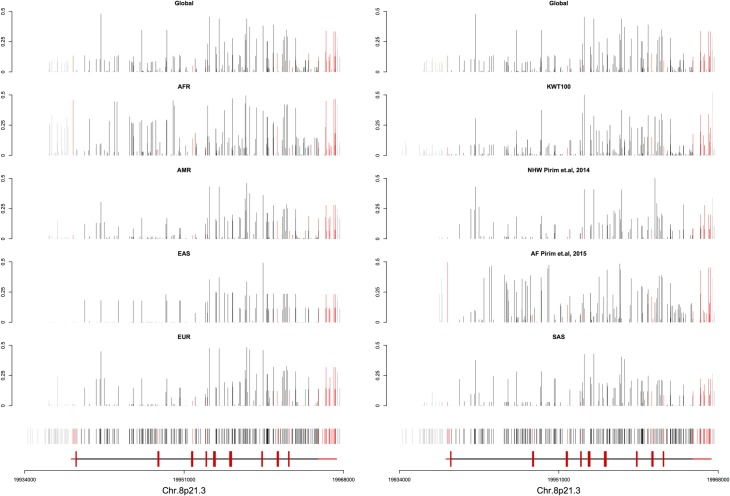
Comparison of the frequencies of rare (a) and common (b) variants identified at the LPL gene locus in the Kuwaiti Arab samples (n = 100), non-Hispanic whites (n = 95; Pirim et al., 2014) and American Africans (n = 95; Pirim et al., 2015). The variants identified in this study are shown based on their location across the 30Kb gene. The minor allele frequencies are based on gene build 89 and genome assembly GRCh38 [26].